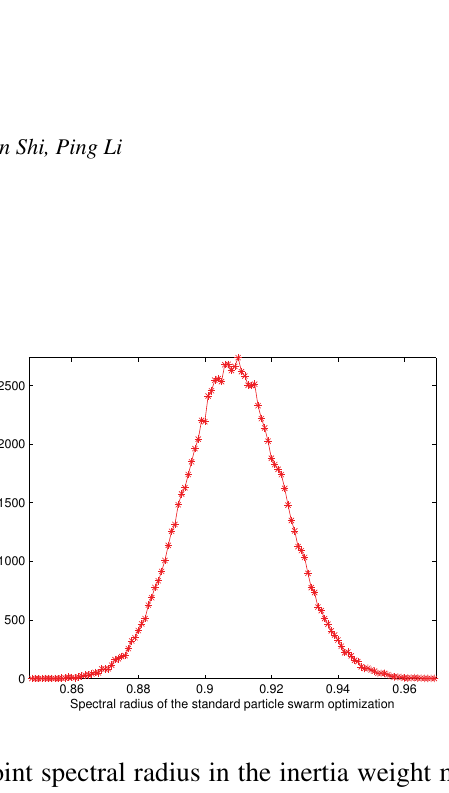
Figure 7: The distribution of the joint spectral radius in the inertia weight method, where the number of inde- pendent runs is 100000 and the number of generations in each run is 500 times.